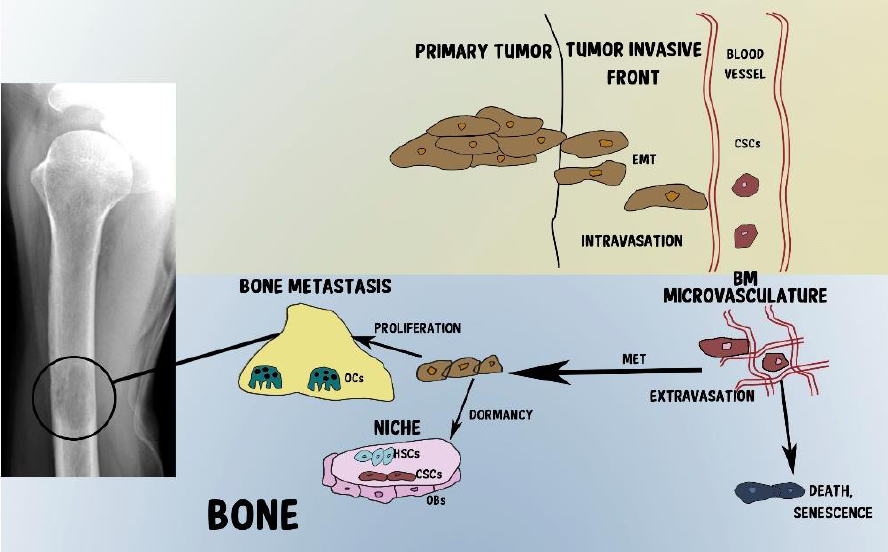
Figure 1. Cancer stem cells’ (CSCs) steps toward bone metastasis. At the primary tumor, cancer cells grow and can perform epithelial-to-mesenchymal transition (EMT), which confers them with invasive properties and consequent intravasation in the circulation. Once they have reached the BM microvasculature, CSCs can undergo senescence and cell death, or colonize the BM, regaining their original epithelial phenotype through a mesenchimal-to-epithelial transition (MET). Then CSCs can enter into a quiescent state (dormancy) in the BM niches, where osteoblasts (OBs) contribute to dormancy, or they can proliferate, releasing factors activating osteoclasts (OCs) and forming bone lesions.